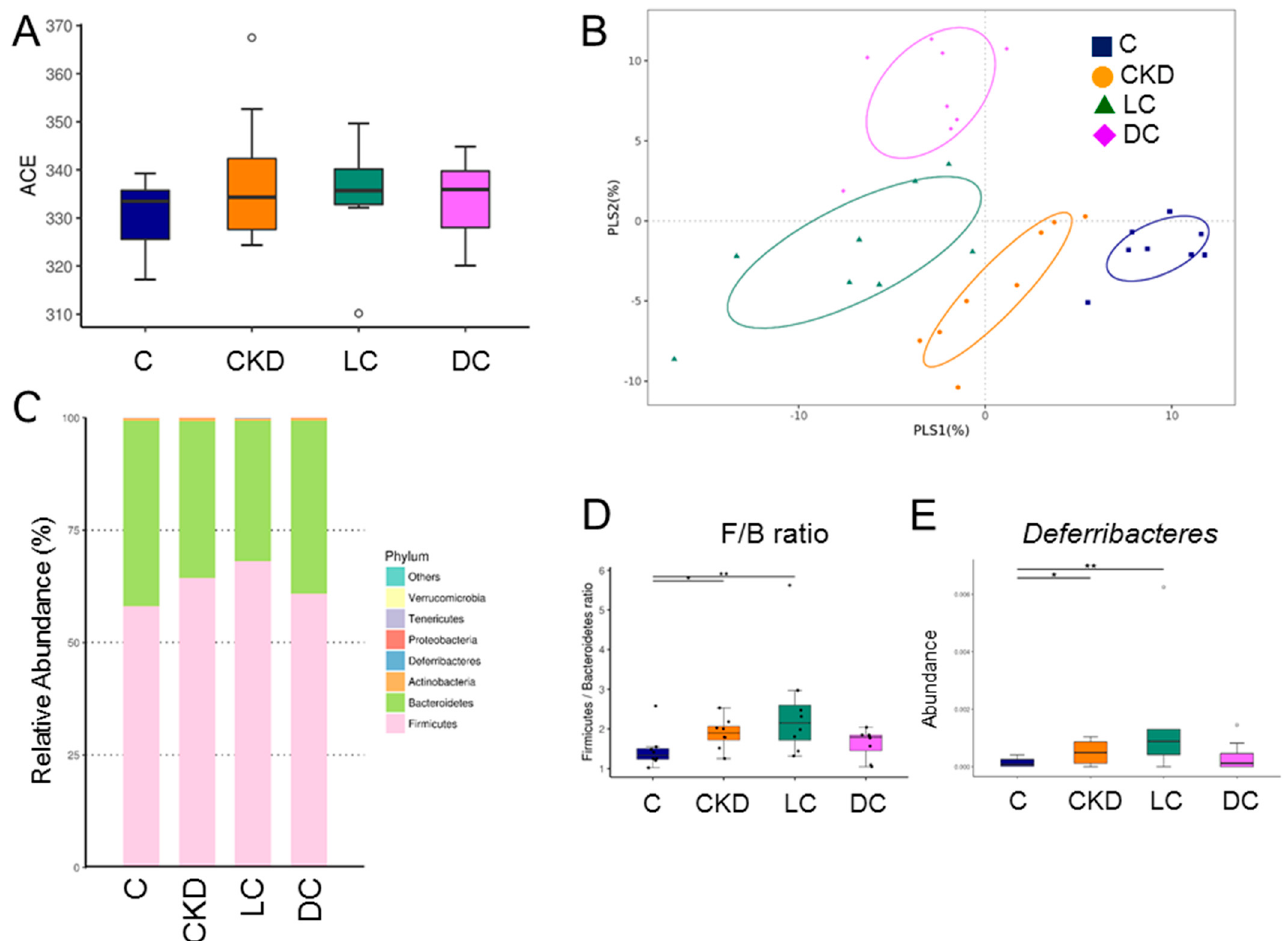
Figure 5. Effect of maternal chronic kidney disease (CKD), L -cysteine (LC), and D -cysteine (DC) on the gut microbiome. ( A ) α -diversity measured by abundance-based coverage estimator (ACE) index. ( B ) β -diversity using the Partial Least Squares discriminant analysis (PLS-DA). ( C ) Relative abundance of the top five phyla of the gut microbiota. ( D ) The Firmicutes to Bacteroidetes (F/B) ratio. ( E ) Relative abundance of the phylum Deferribacteres . Data are shown as means ± SEM; n = 8/group. * p < 0.05; ** p < 0.01.